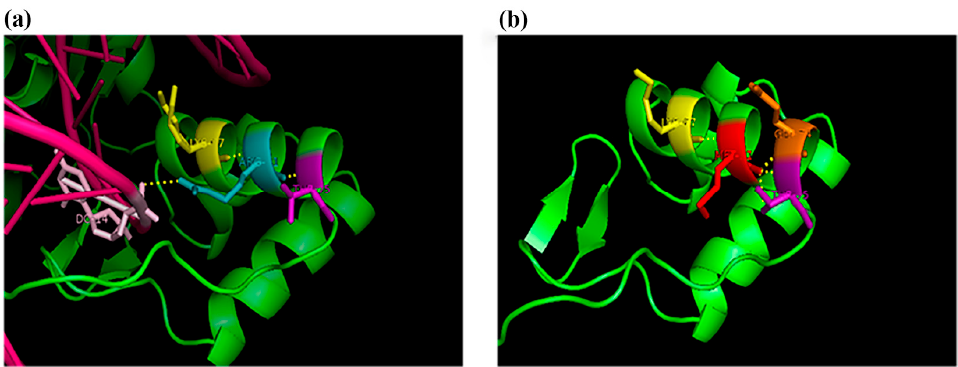
Figure 3. Detail of the 3D structures by PyMol visualization. ( a ) wild-type PAX5 paired-box domain with DNA interaction retrieved from PDB 1k78 structure: Arg71 (light blue) is the conserved amino acid; ( b ) 3D structure of PAX5 paired-box domain, elaborated by SWISS-MODEL prediction tool: the amino acid variant Met71 (magenta) seems to change the orientation of the alpha helix.